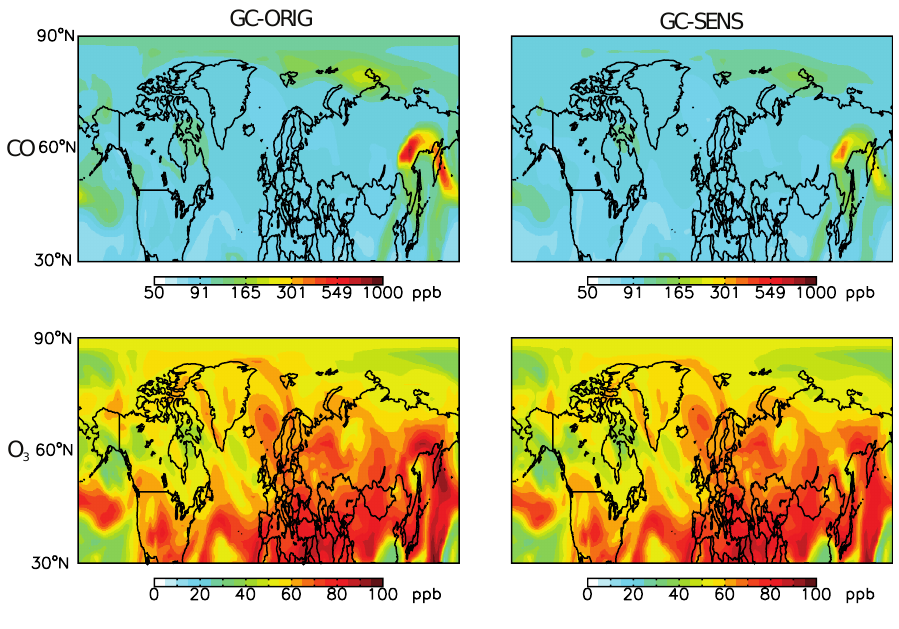
Fig. 8. Mixing ratios of CO and ozone at 510hPa in the original GEOS-Chem simulation (GC-ORIG) and in the emissions sensitivity case (GC-SENS) for 4 July 2008. Note that the different emissions started on 15 June 2008.